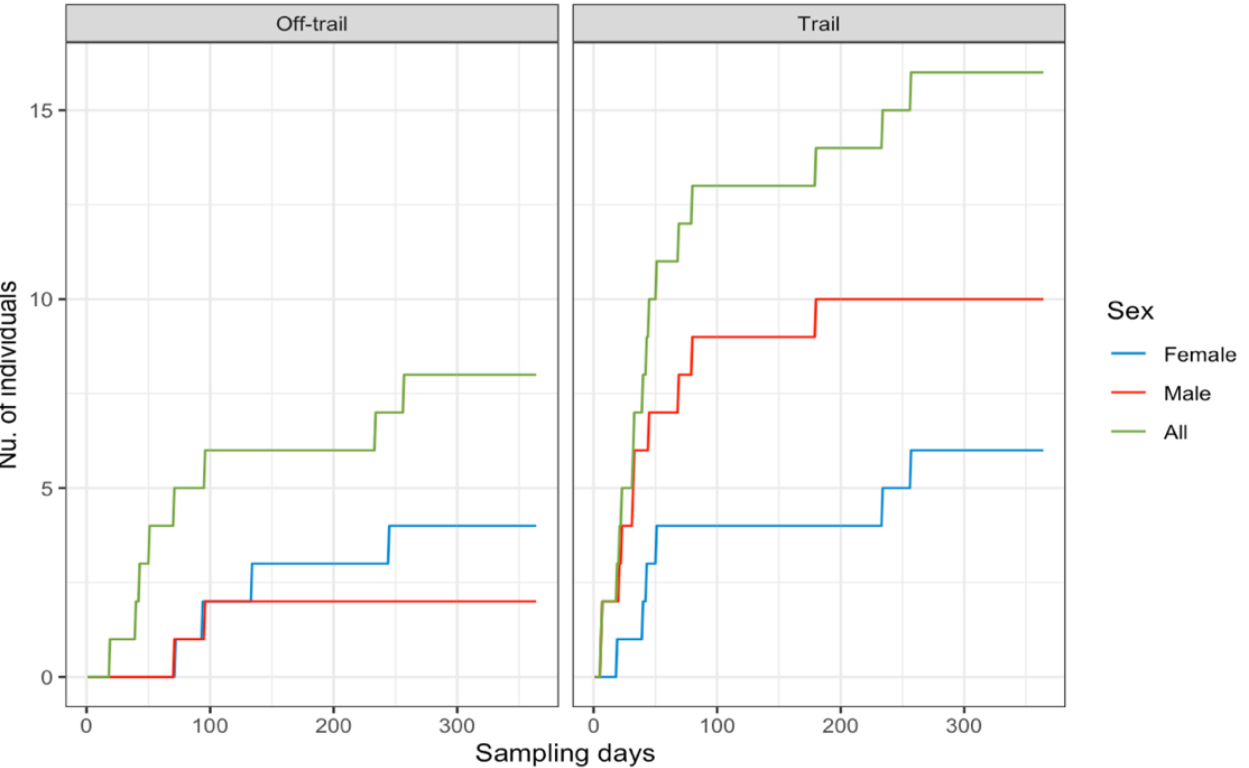
Figure 2. Accumulated number of jaguar individuals by sex at trail/off trail camera placement locations across sampling days for a jaguar camera trap density study in Sector Santa Rosa, Guanacaste Conservation Area, Northwestern Costa Rica.